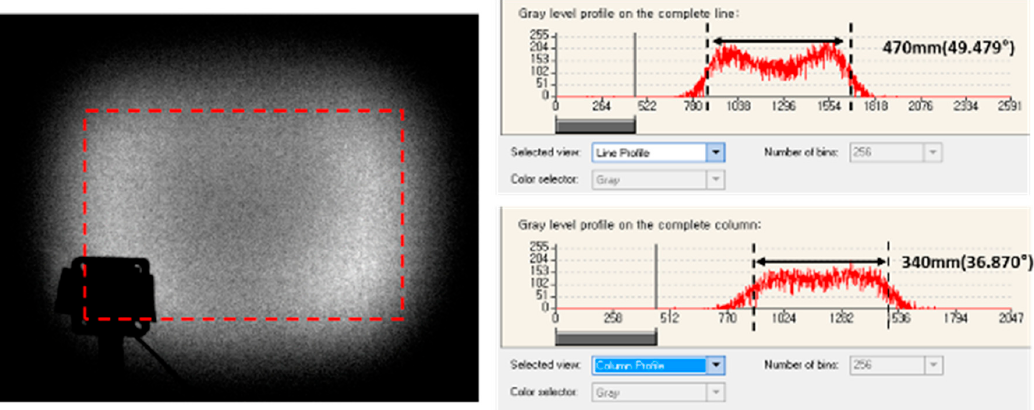
Figure 8. FOV measurement results of the final product sample before compensating for the shrinkage effects.